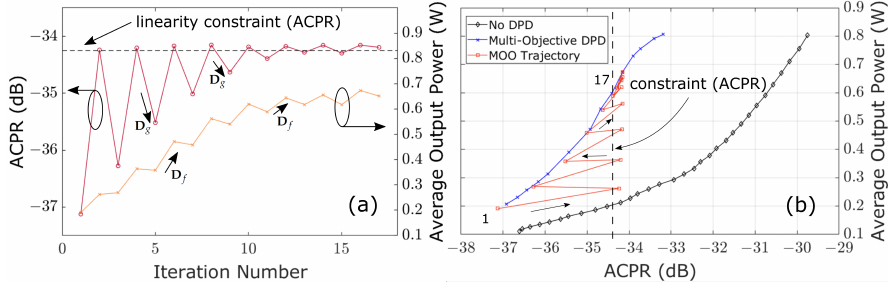
Figure 10. ( a ) Iterative behavior of the algorithm, where the conflicting optimization directions D g (constraint) and D f (maximization) are indicated; ( b ) iterative optimization trajectory (iterations 1 to 17) of the proposed multi-objective algorithm on the same domain as Figure